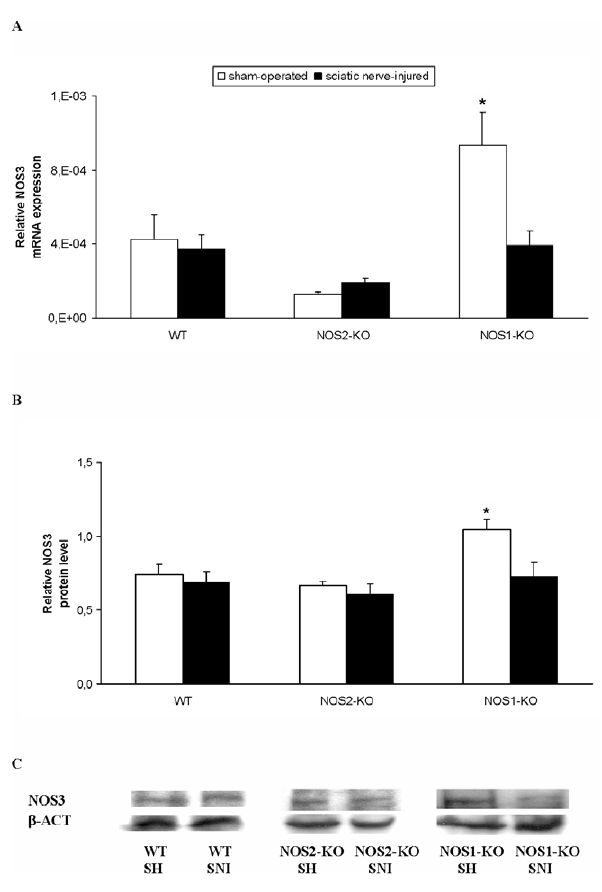
Figure 4. Spinal cord expression of NOS3 in WT, NOS2-KO and NOS1-KO mice. The relative NOS3 mRNA ( A ) and protein ( B ) expression in the ipsilateral site of the lumbar section of the spinal cord from sham-operated (SH) and sciatic nerve-injured (SNI) WT, NOS2- KO and NOS1-KO mice at 21 days after sciatic nerve ligation are represented. In both figures, * indicates significant differences when compared sham-operated NOS1-KO animals vs. the other groups. (* p , 0.05, one-way ANOVA followed by Student-Newman-Keuls test). A representative example of Western blot for NOS3 protein (140 kDa) in which b -actin (43 kDa) was used as a loading control is shown in C . Data are expressed as mean values 6 SEM; n=4–5 samples per